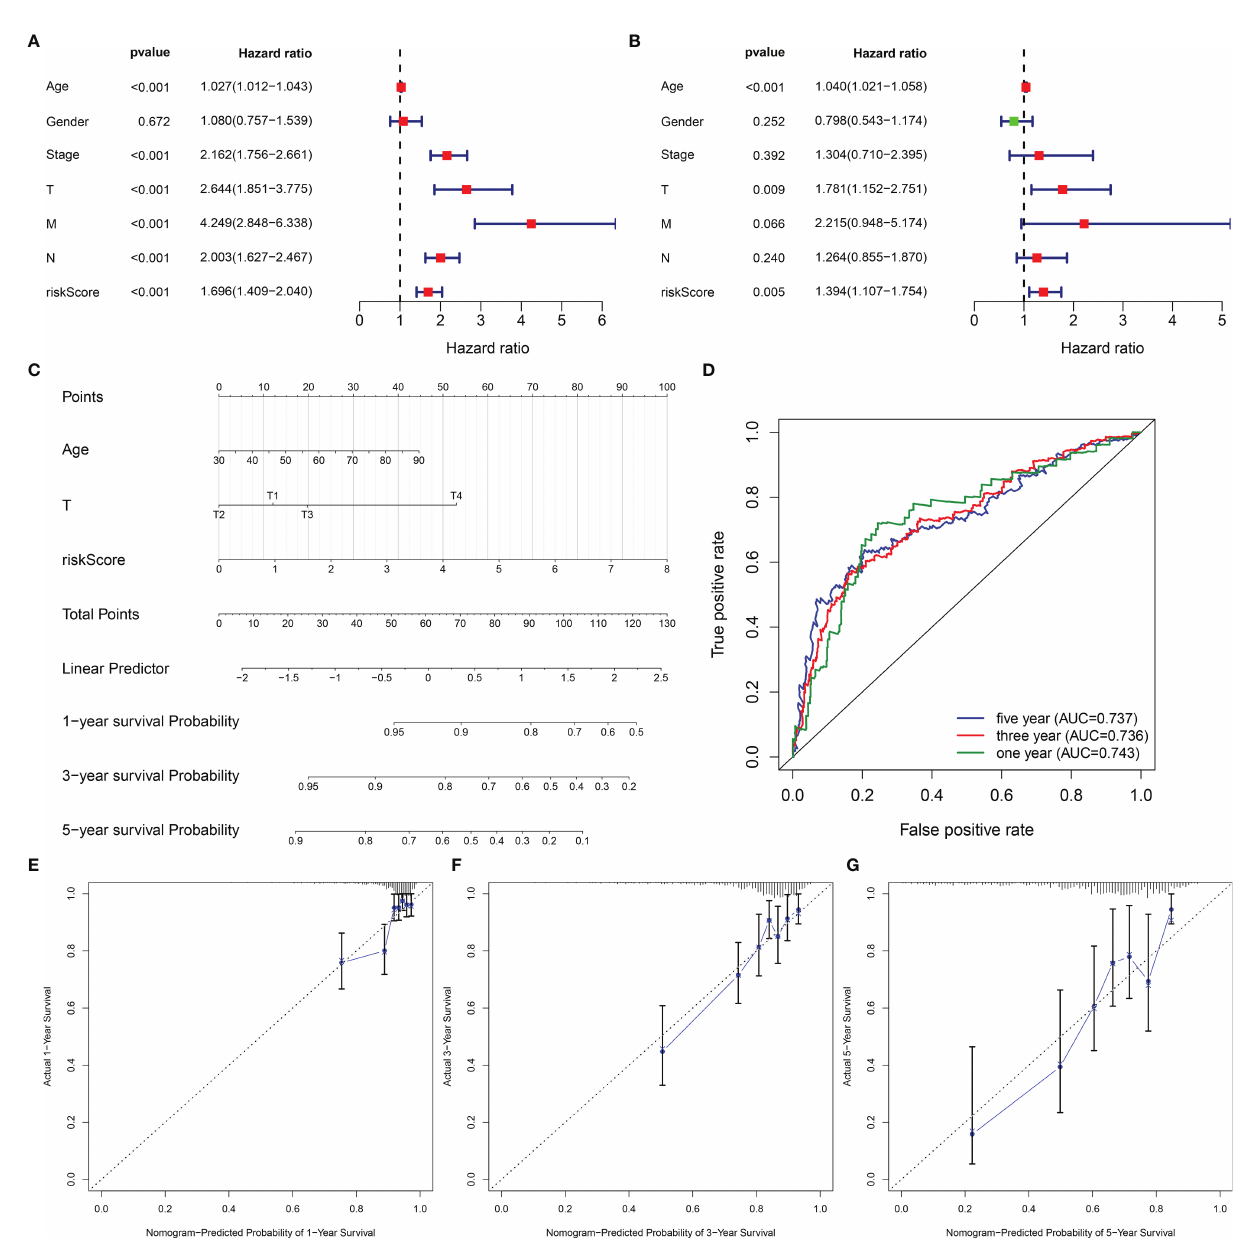
FIGURE 9 | Establishment of a reliable nomogram for prediction of CRC prognosis. (A, B) Uni- and multivariate Cox regression models are conducted to uncover the association of clinical features and EVA1B-derived risk score with CRC survival outcome. (C) A prognostic nomogram is exploited through integrating independent prognostic indicators (age, T stage, and EVA1B-derived risk score) to estimate 1-, 3-, and 5-year survival probability. (D) Predictive ef fi cacy of this nomogram is veri fi ed through ROC curves at 1-, 3-, and 5-year survival. (E – G) Calibration plots show the association of predicted 1-, 3-, and 5-year OS with actual survival